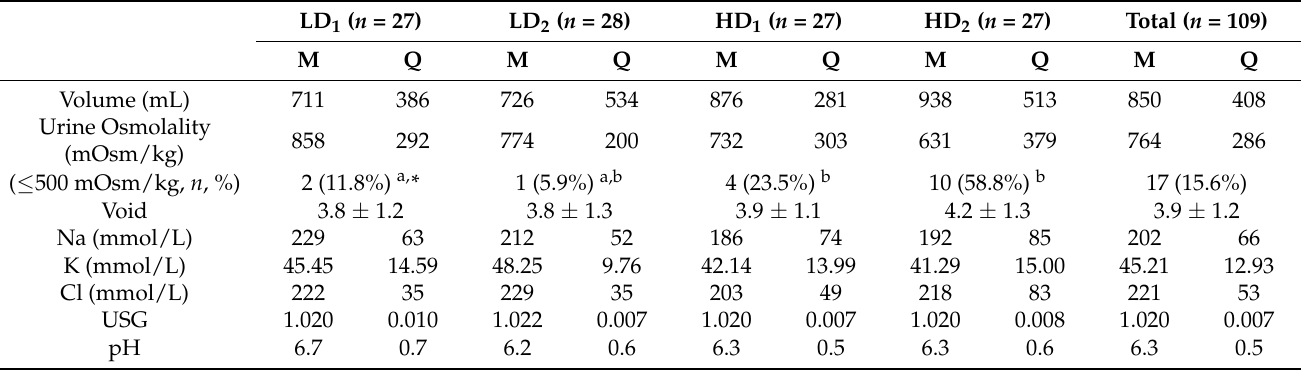
Table 3. The characteristics of 24-h urine among participants consuming different levels of total drinking fluids.